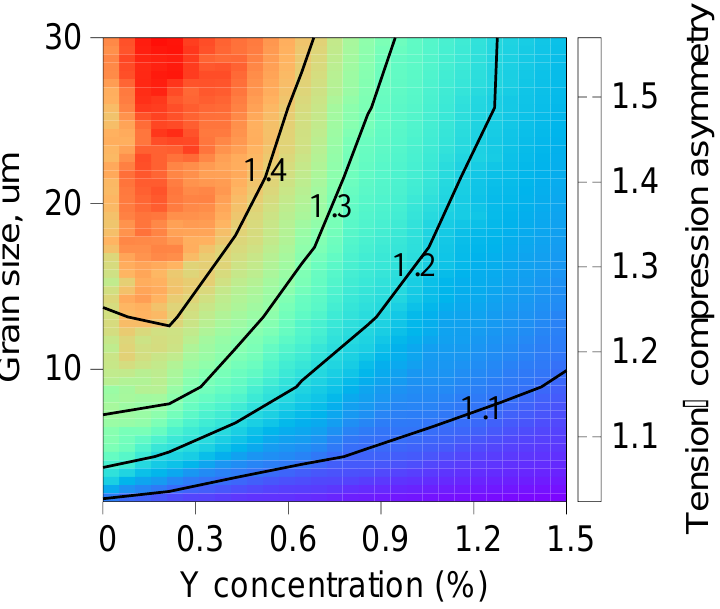
Figure 10. The distribution of tension–compression asymmetry for the TD1 direction loading of the initial extrusion texture is given in Figure 4.